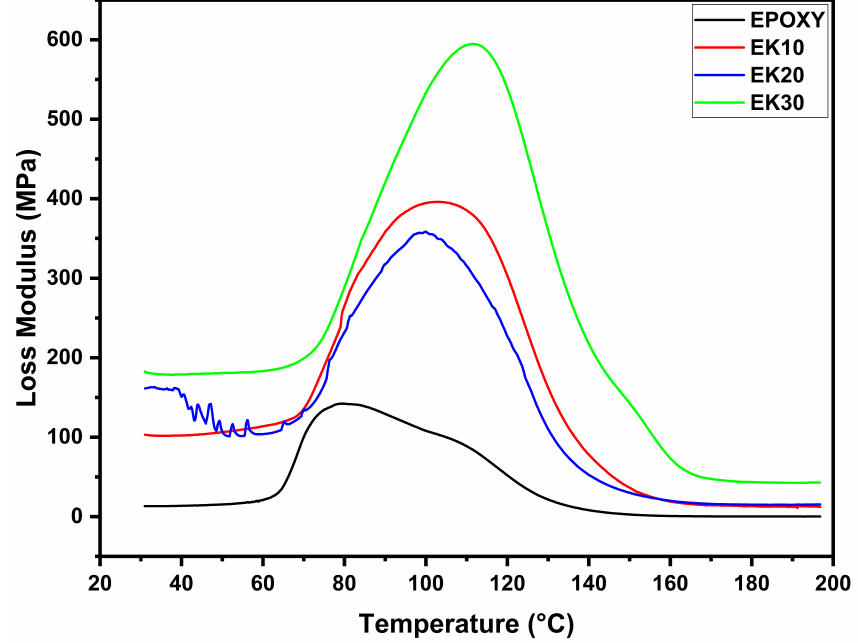
Figure 4. DMA loss modulus (E”) curves for epoxy composites incorporated with different amounts of kenaf